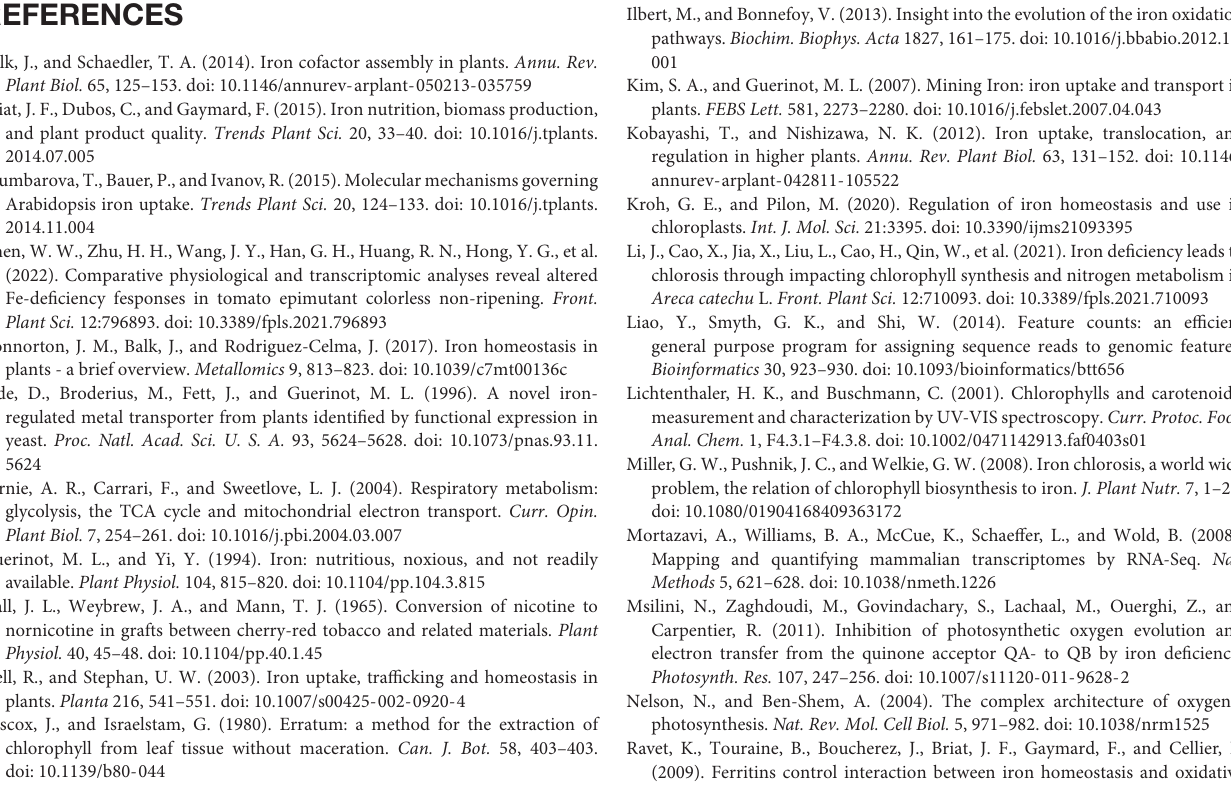
Supplementary Table 2 | List of GO terms of CR60 under iron deficiency conditions. Supplementary Table 3 | List of GO terms of Y87 under iron deficiency conditions. Supplementary Table 4 | List of KEGG terms of CR60 under iron deficiency conditions. Supplementary Table 5 | List of KEGG terms of Y87 under iron deficiency